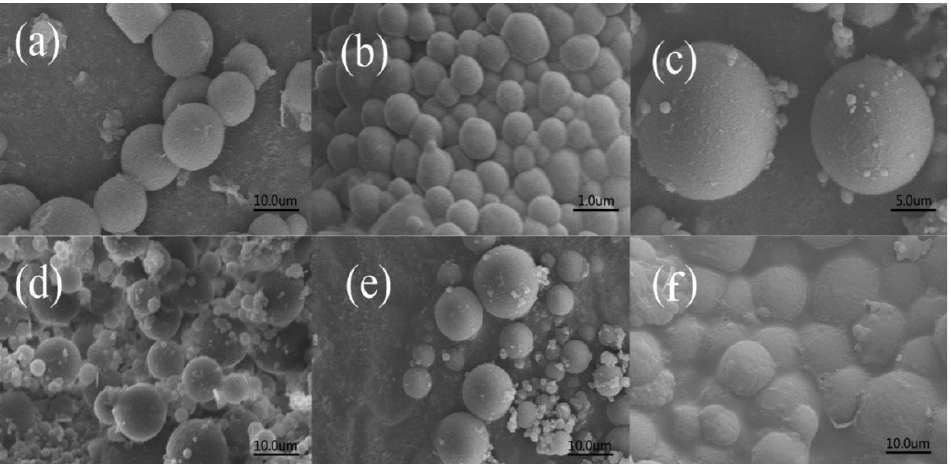
Figure 4: SEM micrographs of (a) HA-AMA, (b) HA-BDDA, (c) HA-PETRA, (d) HA-TMPTA, (e) HA-DVB, (f)